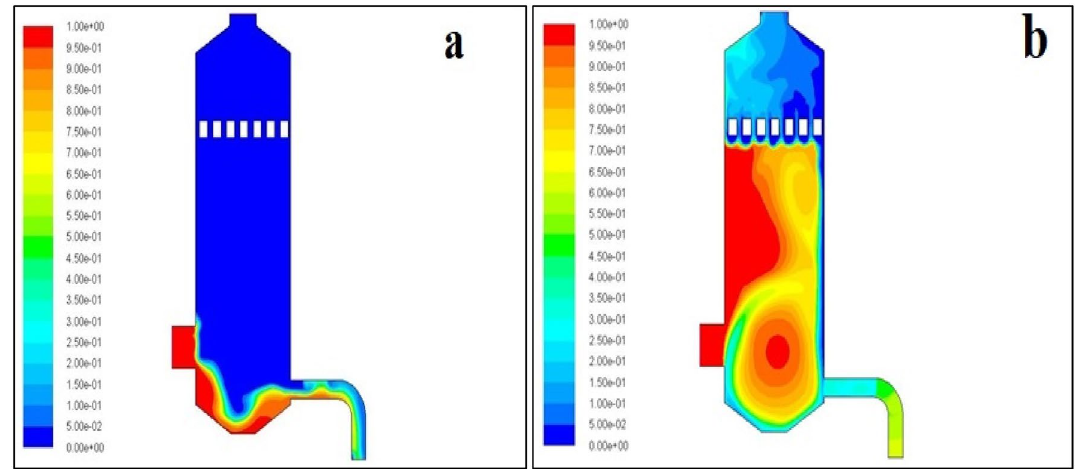
Figure 3. ( a ) Volume fraction of dust, ( b ) volume fraction of flue